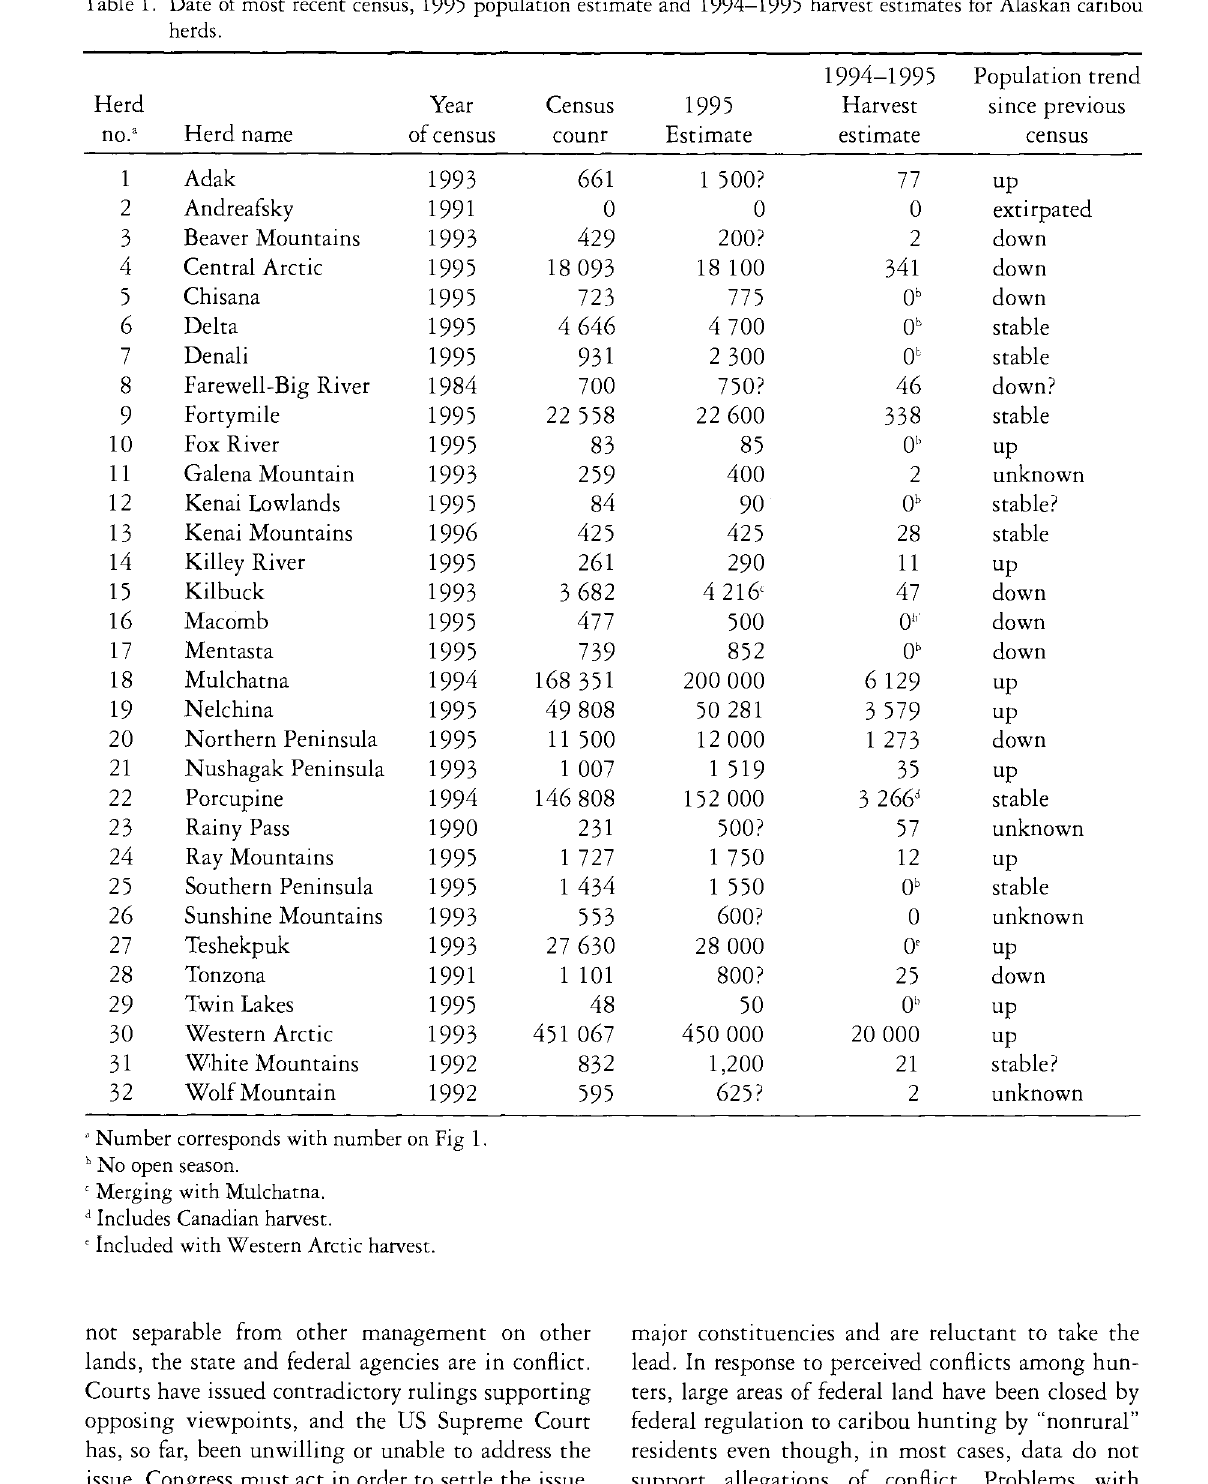
Table 1. Date of most recent census, 1995 population estimate and 1994-1995 harvest estimates for Alaskan caribou